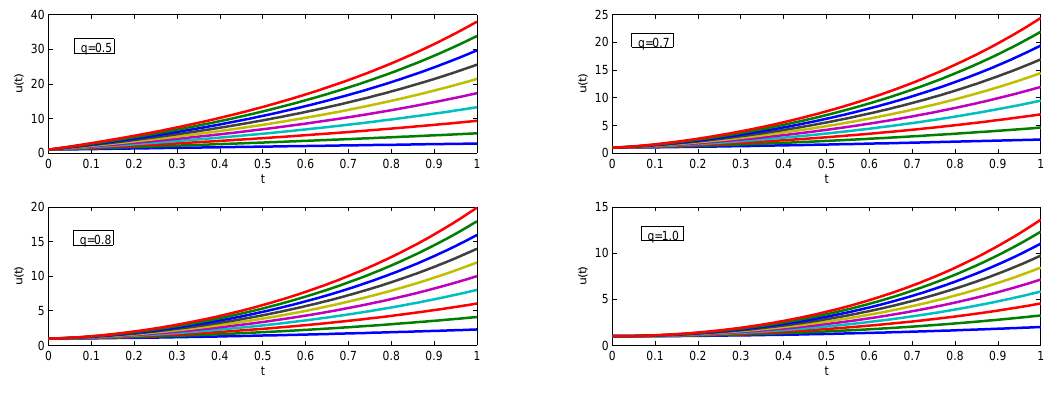
) q when q = 0 . 5 , 0 . 7 , 0 . 8 , 1 . 0 . 0